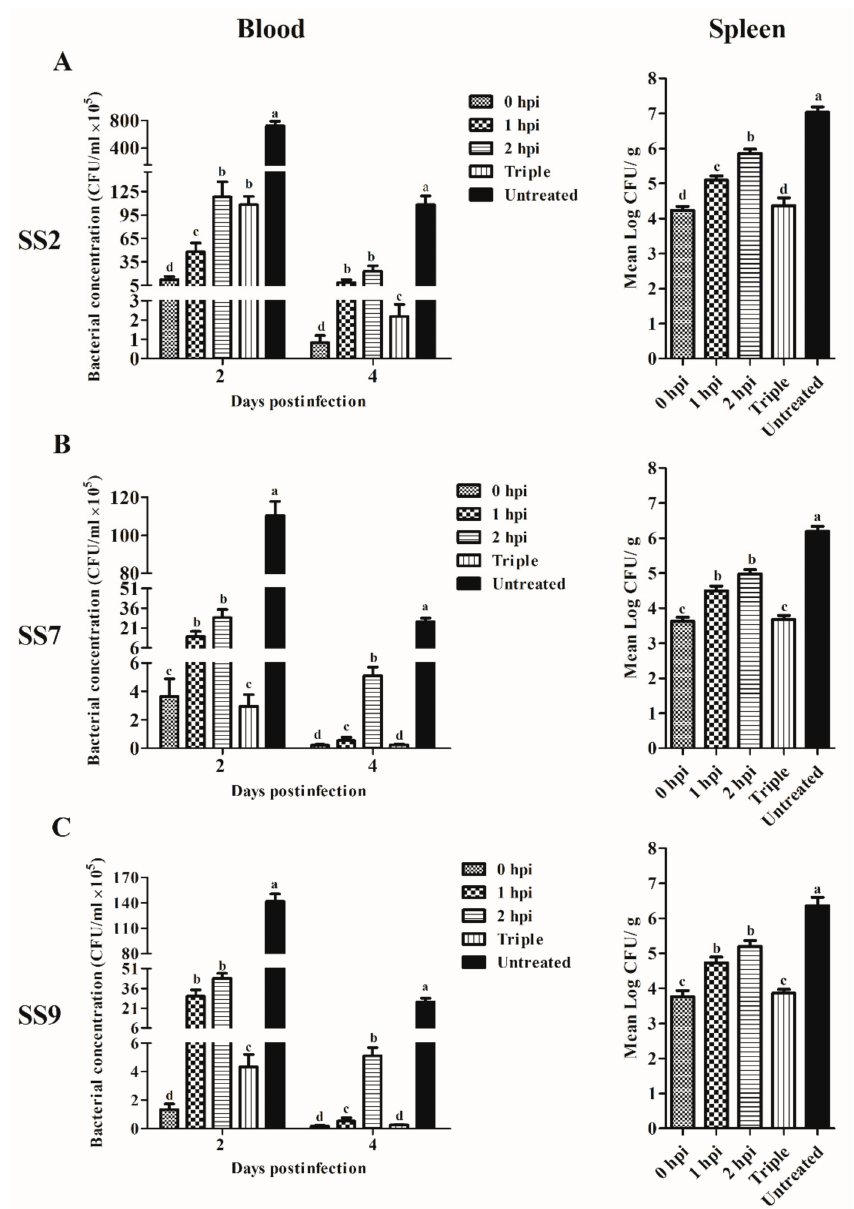
Figure 5. The bacterial burden in murine blood and spleen (2 and 4 d post infection) following bacterial challenge with SS2 ( A ), SS7 ( B ), and SS9 ( C ). Ply5218 was administered at 0, 1, or 2 h post